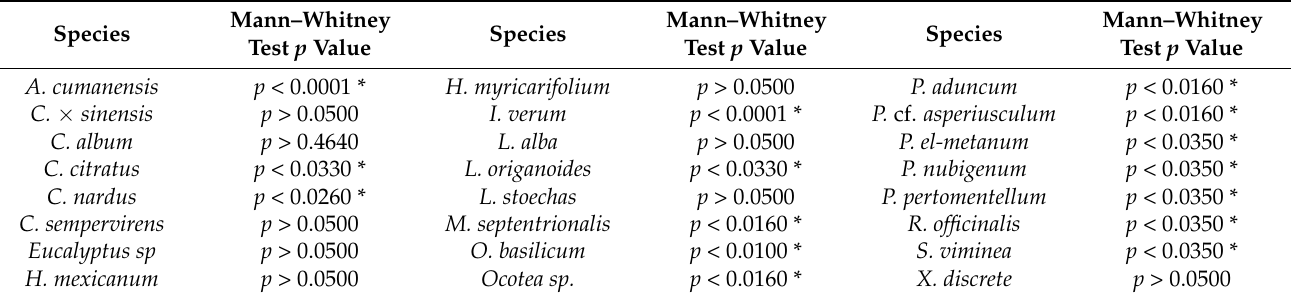
Figure 4. Comparisons of mortality presented in the screenings of insecticidal activity and the fumigant activity test. Table 1. Results of the Mann–Whitney test for the comparison of mortality presented in the screening of insecticidal activity and the fumigant activity test.